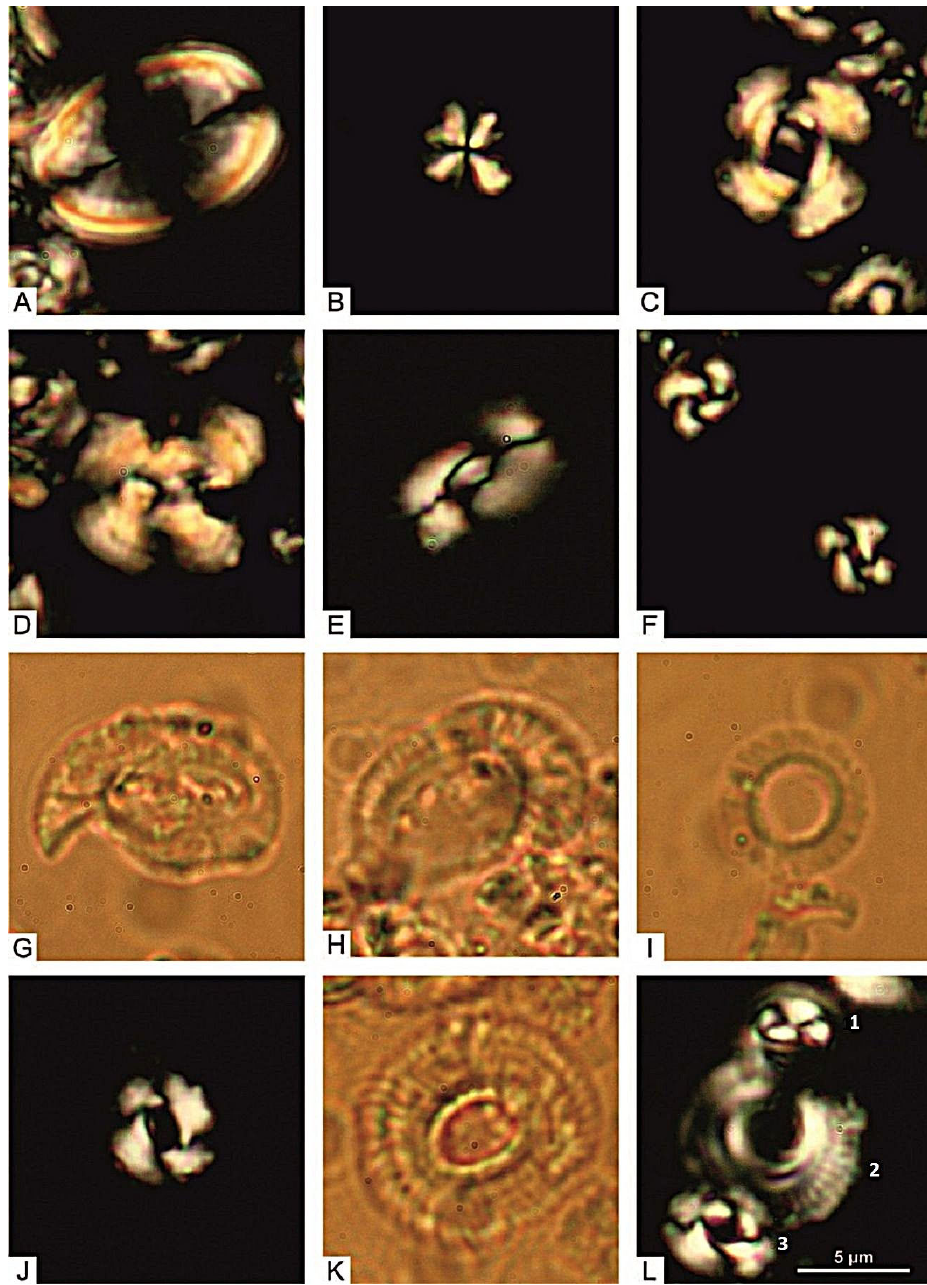
Figure 13. Coccolithophores from the Marija Bistrica site (see Figure 10). ( A ) Pontosphaera discopora Schiller, 1925; ( B ) Sphenolithus moriformis (Bronnimann and Stradner, 1960) Bramlette and Wilcoxon, 1967; ( C ) Reticulofenestra dictyoda (Deflandre in Deflandre and Fert, 1954) Stradner in Stradner and Edwards, 1968; ( D ) Reticulofenestra bisecta (Hay, Mohler and Wade, 1966) Roth, 1970; ( E ) Helicosphaera intermedia Martini, 1965; ( F ) Reticulofenestra perplexa (Burns, 1975) Wise, 1983; ( G ) Helicosphaera perch ‐ nielseniae (Haq, 1971) Jafar and Martini, 1975; ( H ) Helicosphaera carteri (Wallich 1877) Kamptner, 1954; ( I ) Umbilicosphaera rotula (Kamptner, 1956) Varol, 1982; ( J ) Reticulofenestra pseudoumbilicus (Gartner, 1967) Gartner, 1969; ( K ) Calcidiscus premacintyrei Theodoridis, 1984; ( L ) 1. Coccolithus pelagicus (Wallich, 1977); 2. Calcidiscus tropicus (Kamptner, 1956) Varol 1989 sensu Gartner, 1992; 3. Reticulofenestra pseudoumbilicus (Gartner, 1967) Gartner, 1969. Figures. G, H, I and K PPL, others XPL. Scale bar 5 μ m for all figures [59].